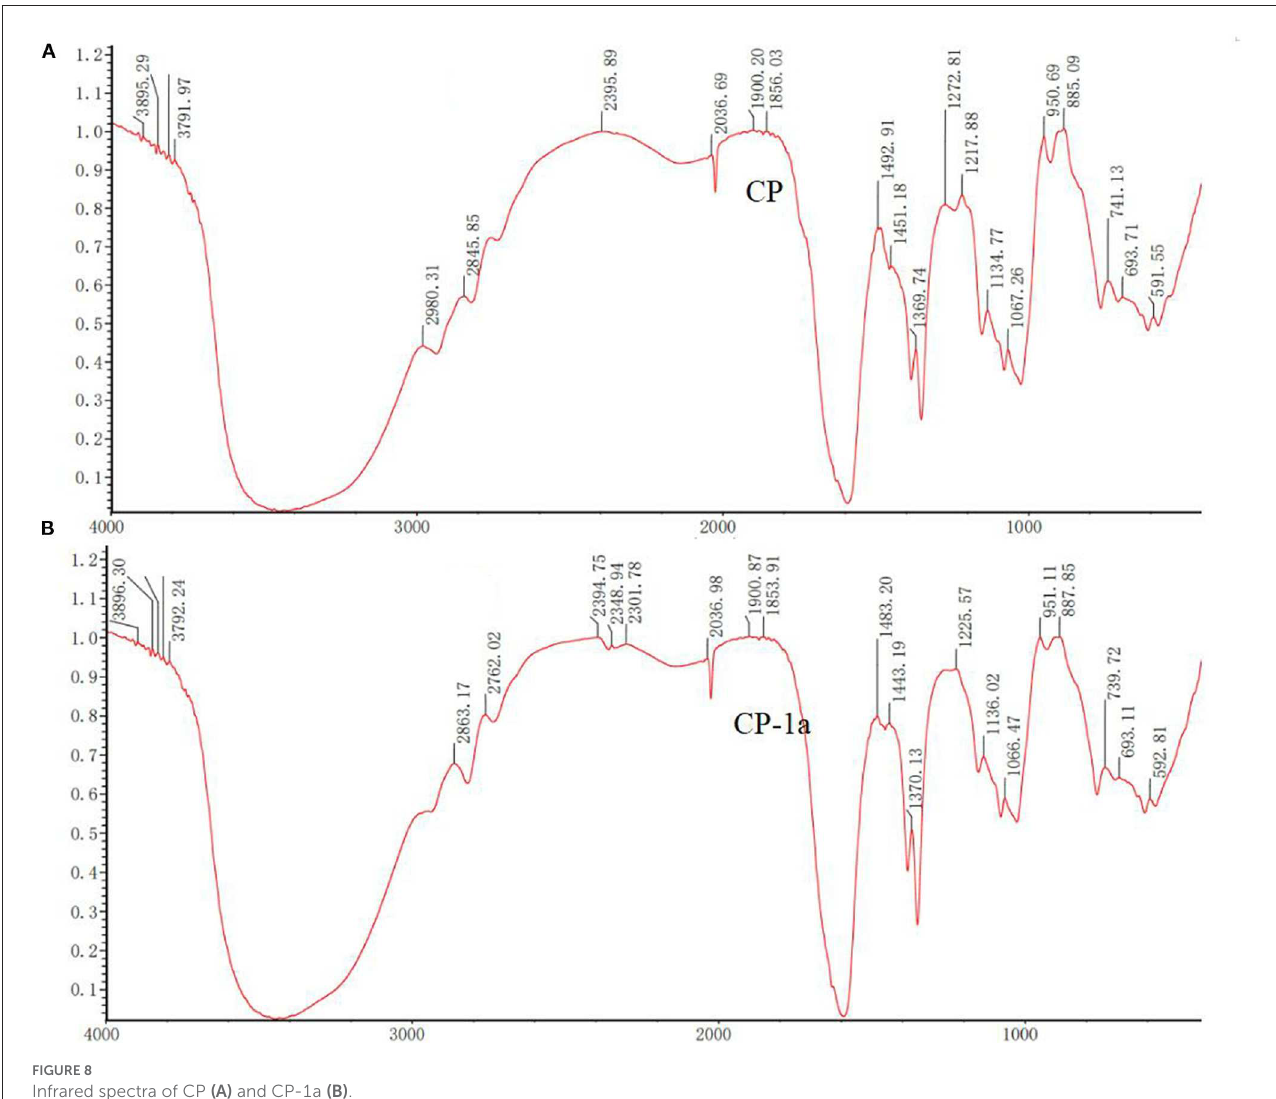
FIGURE8 Infrared spectra of CP (A) and CP-1a (B)